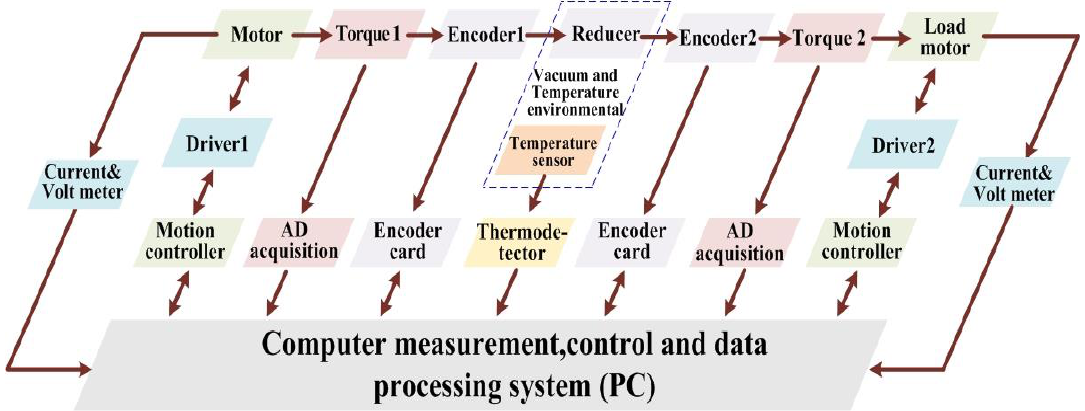
Figure 2. The principle block diagram of space harmonic drive gearing test